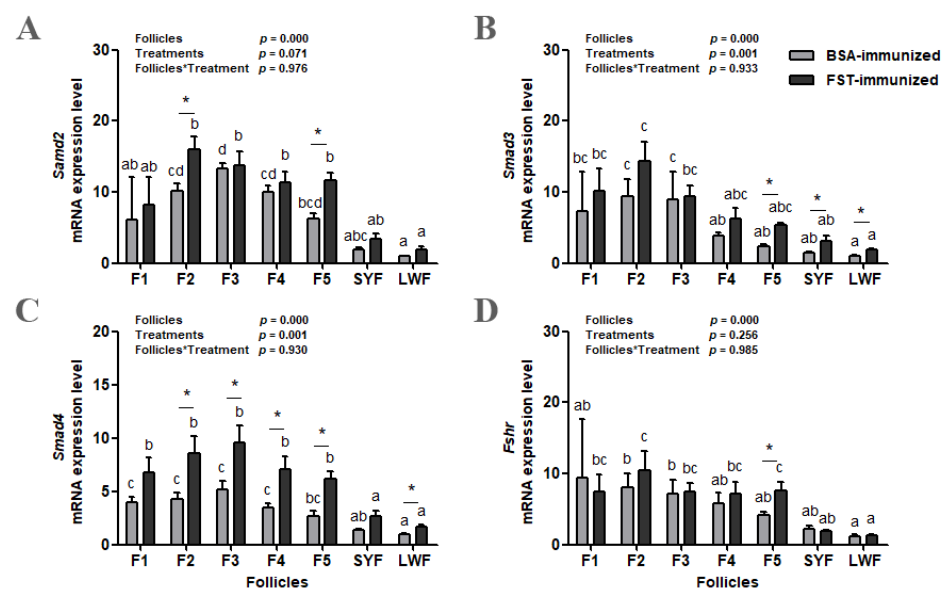
Figure 6. Smad2 ( A ), Smad3 ( B ), Smad4 ( C ), and Fshr ( D ) mRNA levels in granulosa layers from ovarian pre-hierarchical follicles (SYFs and LWFs) and pre-ovulatory follicles (F1 to F5) in FST-immunized or BSA-immunized control geese ( n = 6). For each group, a, b, c represents a significant difference among the means ( p < 0.05). * represents a significant difference between the two groups ( p < 0.05) in one type of follicle. Data represent mean ± SEM.